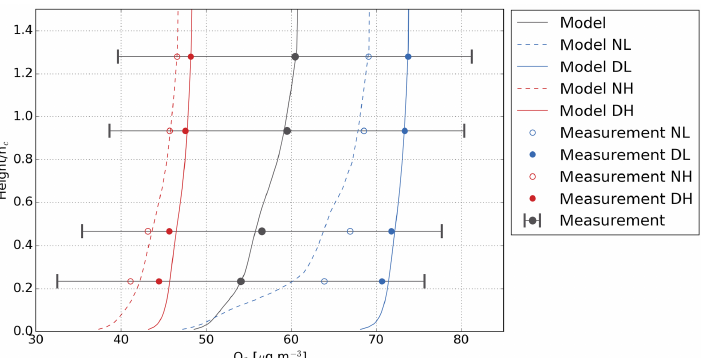
Figure 8. Measured average vertical profiles of O 3 concentration for the whole month (dark grey, the horizontal bars are ± 1SD) and individual conditions (daytime under high humidity condition, labelled as DH with red filled circle; daytime under low humidity condition, labelled as DL with blue filled circle; nighttime under high humidity condition, labelled as NH with red empty circle; nighttime under low humidity condition, labelled as NL with blue empty circle). Modelled results are plotted as solid lines (daytime) and dashed lines (nighttime) with the same colour as measurement. The height is normalised by the canopy height h c .